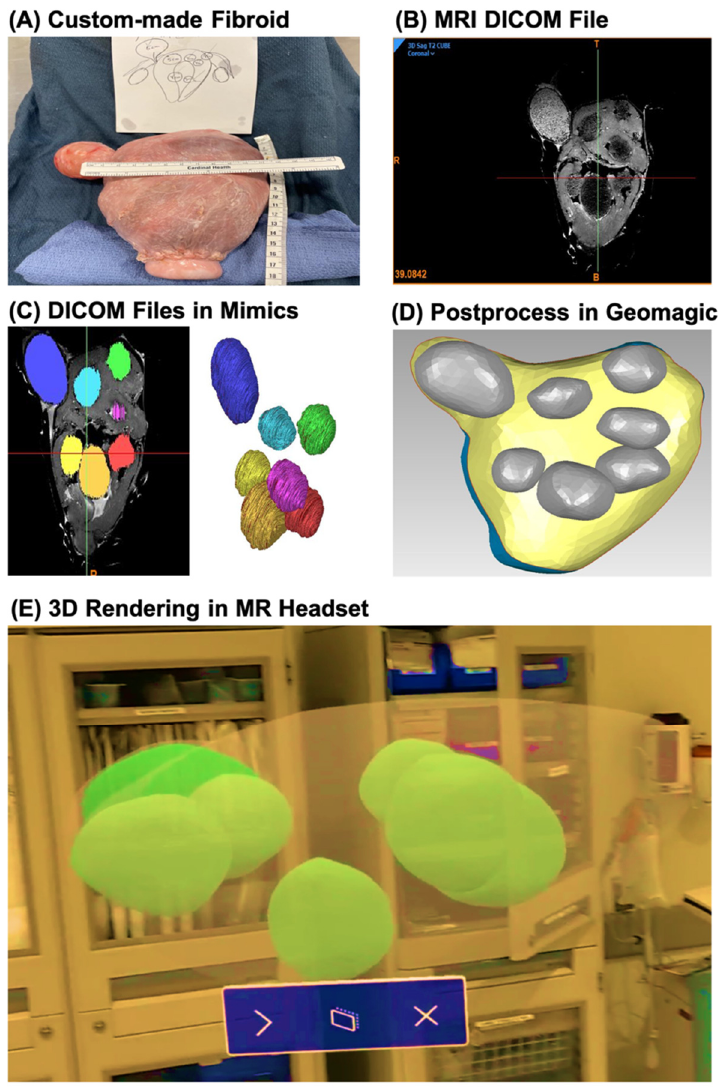
Figure 2. Depicting workflow of building MR hologram from an animal model: ( A ) Uterine fibroid model was custom-made with various bovine muscle layers to simulate the different textures of the uterus and myoma; ( B ) The model was taken for a MRI scan, and a DICOM file was generated; ( C ) In Mimics, the specific thresholds are set to segment the fibroids and uterine wall; ( D ) Then, Geomagic Wrap was used to trim all the artifacts of the 3D segmentation; ( E ) Lastly, after another post-processing to a GLB file, the rendering was launched as a hologram using 3D viewer app of a Microsoft HoloLens 2 headset.